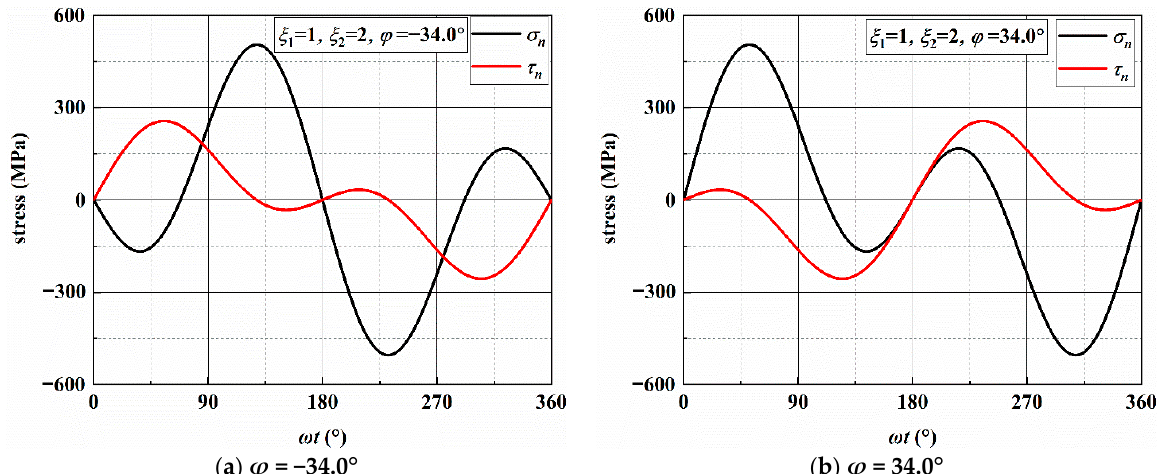
Figure A5. Variation of normal and shear stress on MN plane under AS-3.